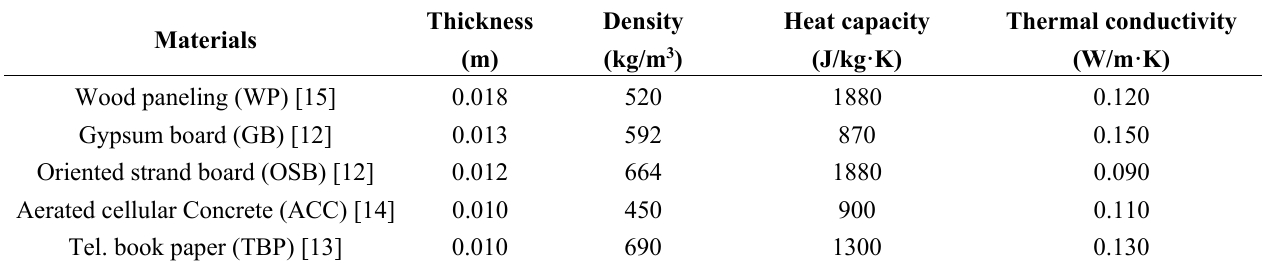
Table 4. Other properties of materials used in this